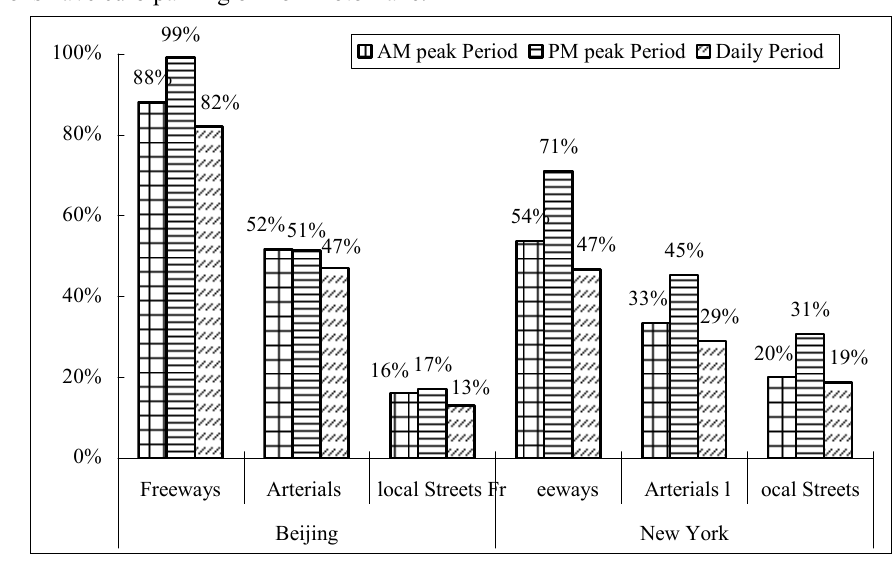
Fig. 3. V/C ratio comparison of different grade road in Beijing and New York